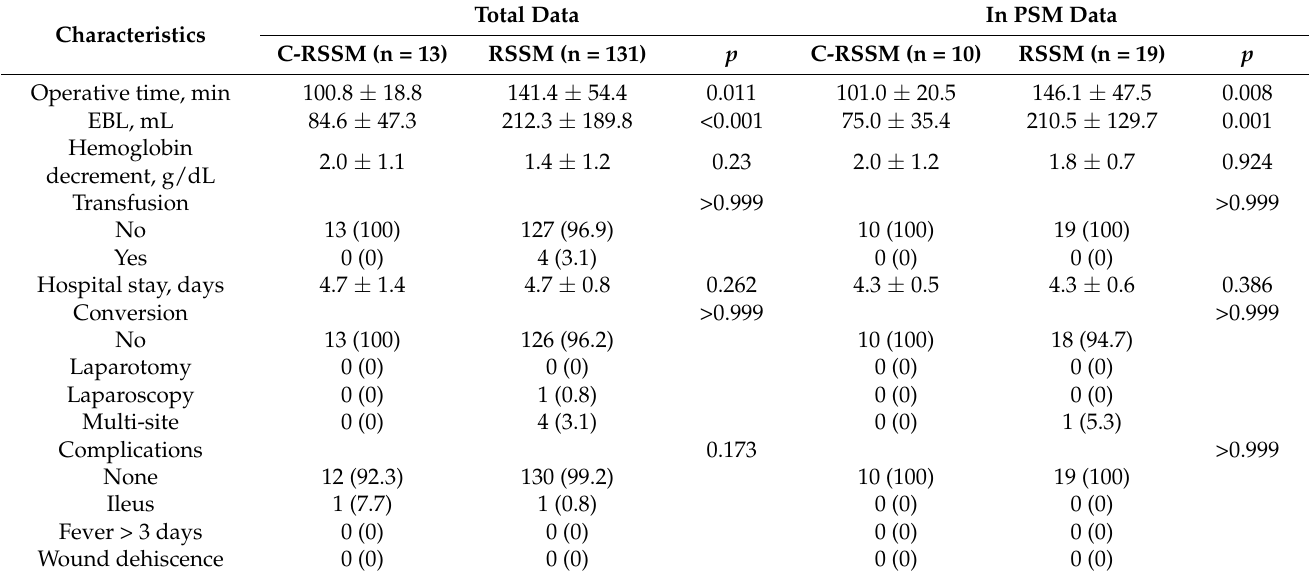
Table 3. Surgical outcomes and morbidity before and after propensity score matching